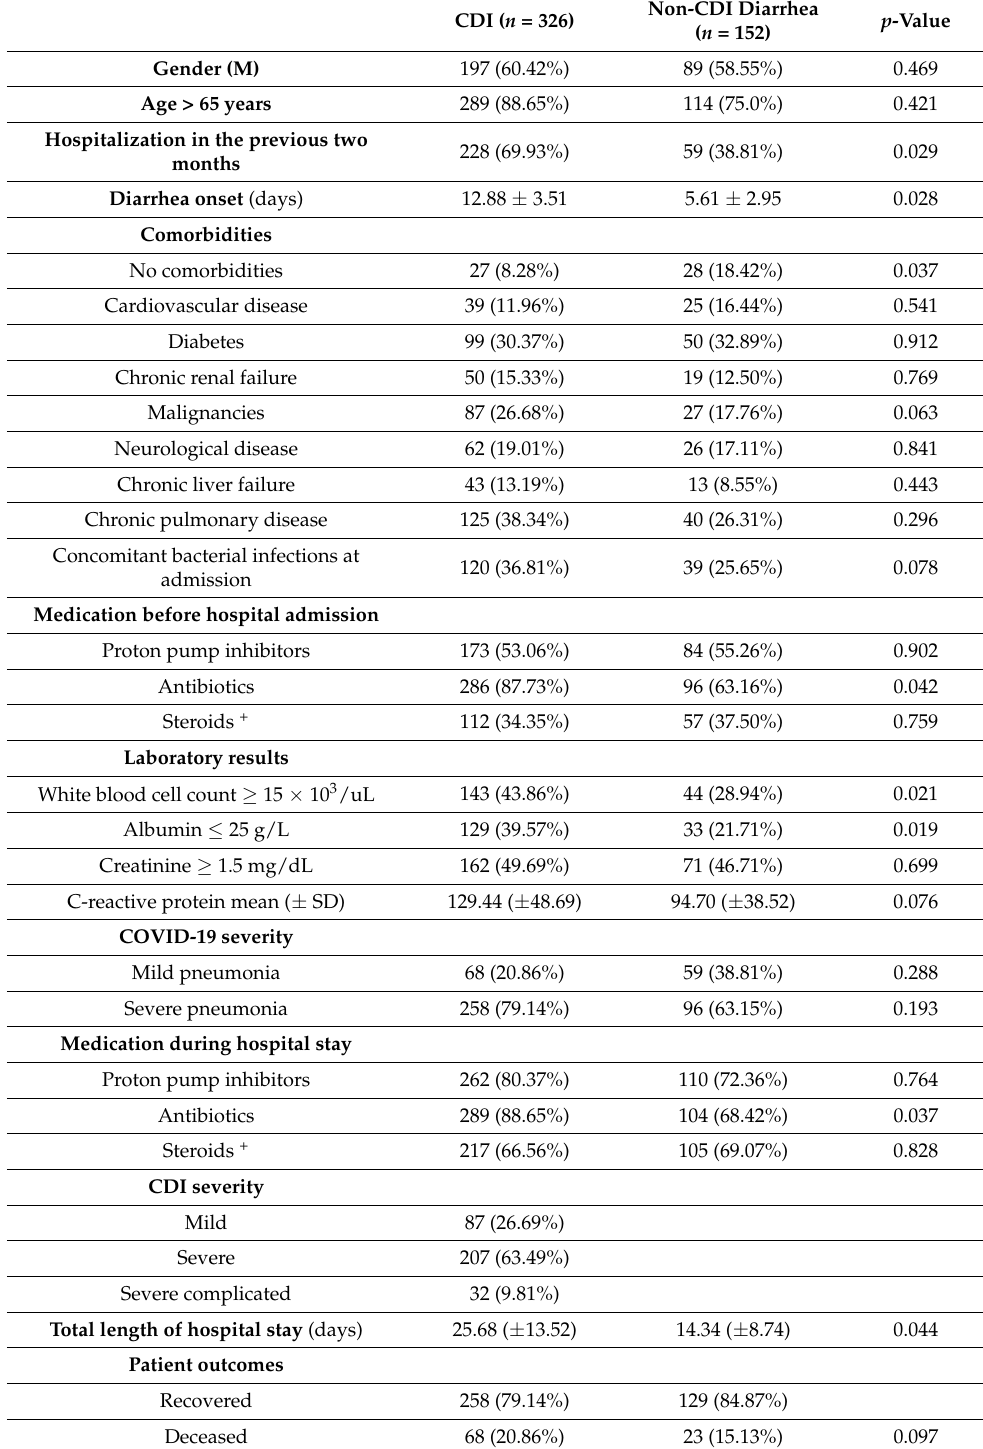
Table 1. Demographic and epidemiological data, clinical characteristics, comorbidities, laboratory results, and outcomes of COVID-19 patients with and without